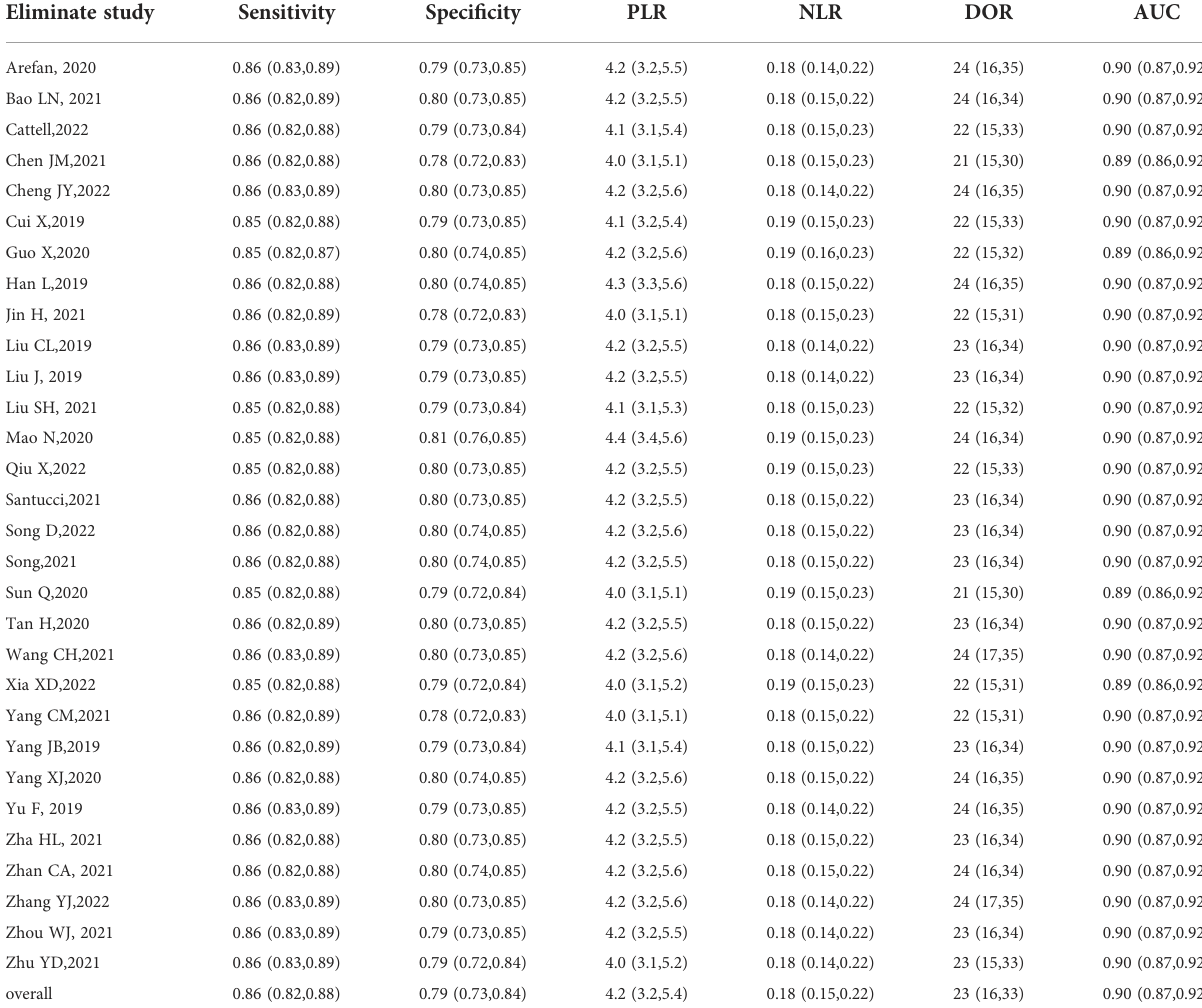
TABLE 3 Sensitivity analysis based on radiomics in predicting ALNM in breast cancer. Eliminate